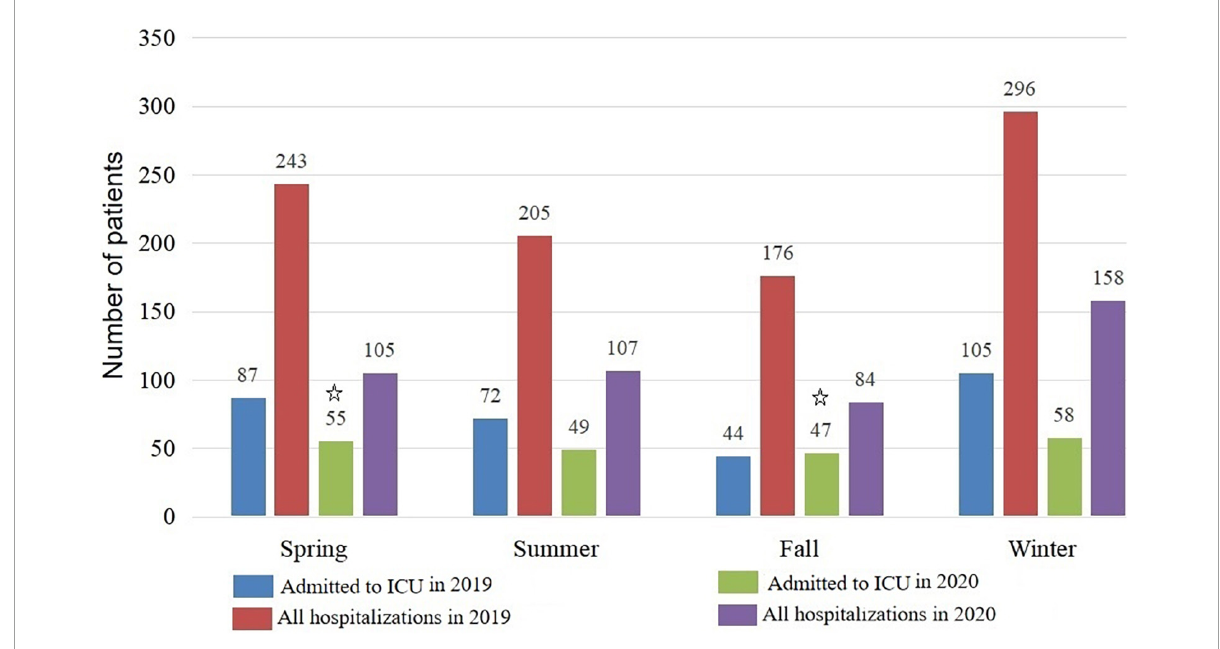
FIGURE2 Distribution of emergency hospitalizations by season due to respiratory diseases. ICU, intensive care unit; the ICU hospitalization rate was higher in spring and autumn of 2020 than the corresponding seasons of 2019 (55.38 vs. 35.8%, χ 2 = 8.343, P = 0.004; 55.95 vs. 25%, χ 2 = 23.946, P = 0.000,